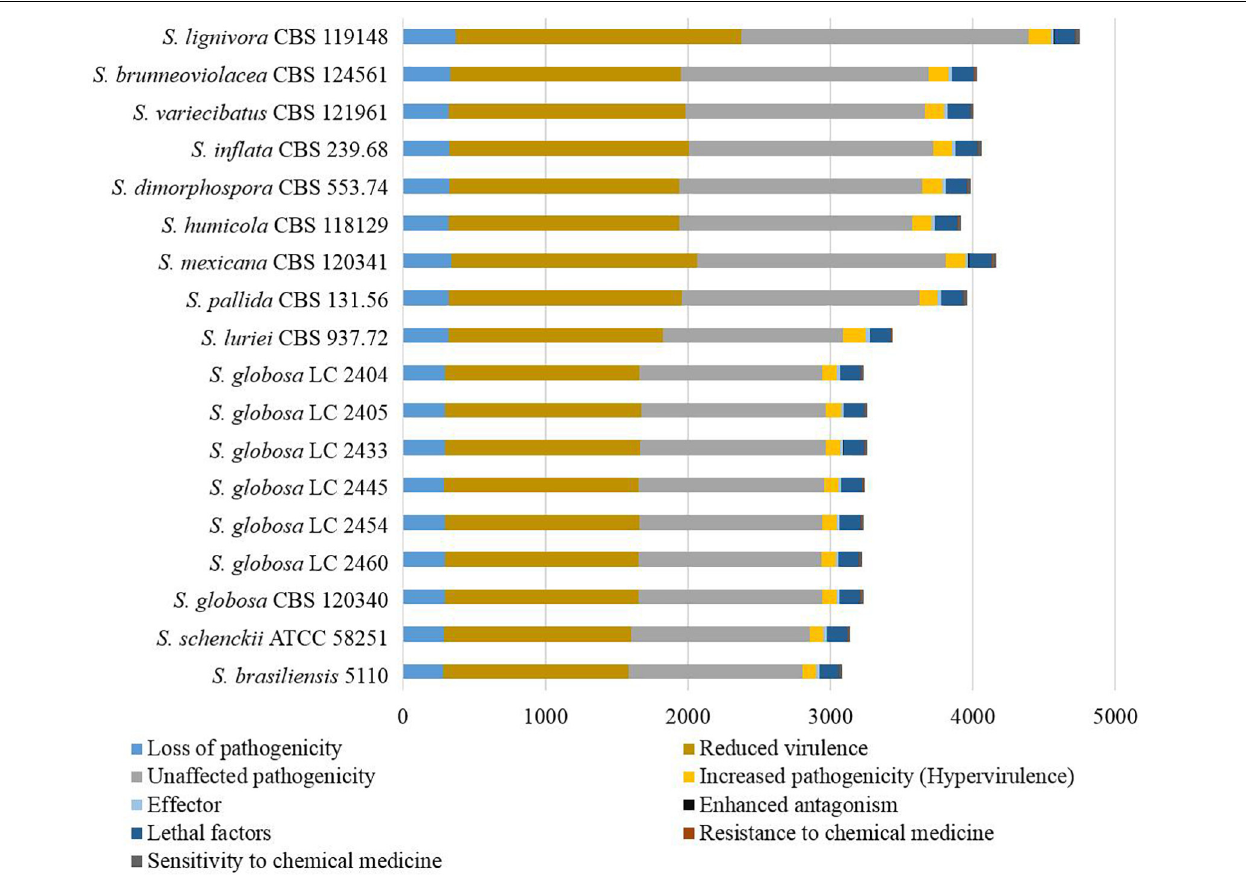
FIGURE 8 | Genes associated with virulence in the genus Sporothrix. From the virulence gene prediction, genes of five classifications, i.e., loss of pathogenicity, reduced virulence, unaffected pathogenicity, increased pathogenicity, and lethal factors in four main clinical species ( S. brasiliensis , S. schenckii , S. globosa, and S. luriei ) were less than those in the environmental and other clinical species, and the reduced number of genes associated with the loss of pathogenicity, reduced virulence and unaffected pathogenicity was far more than that associated with the increased pathogenicity and lethal